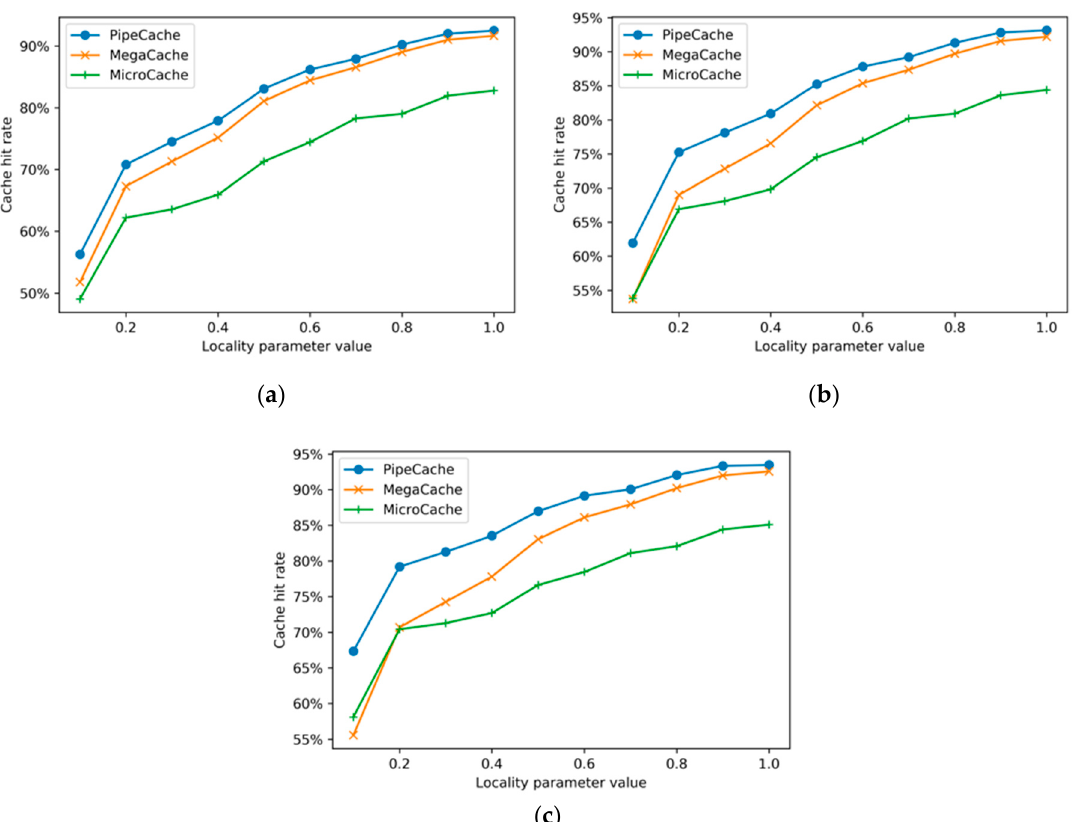
Figure 9. Cache hit rates with different traffic localities. ( a ) Cache rate = 10%. ( b ) Cache rate = 20%. ( c ) Cache rate = 30%